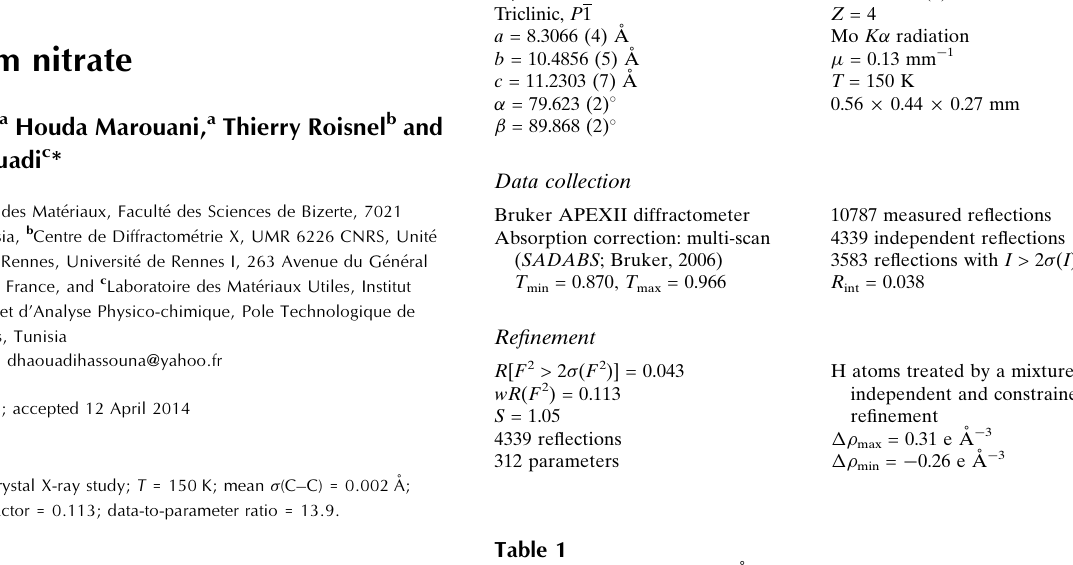
Hydrogen-bond geometry (A˚ , (cid:4)